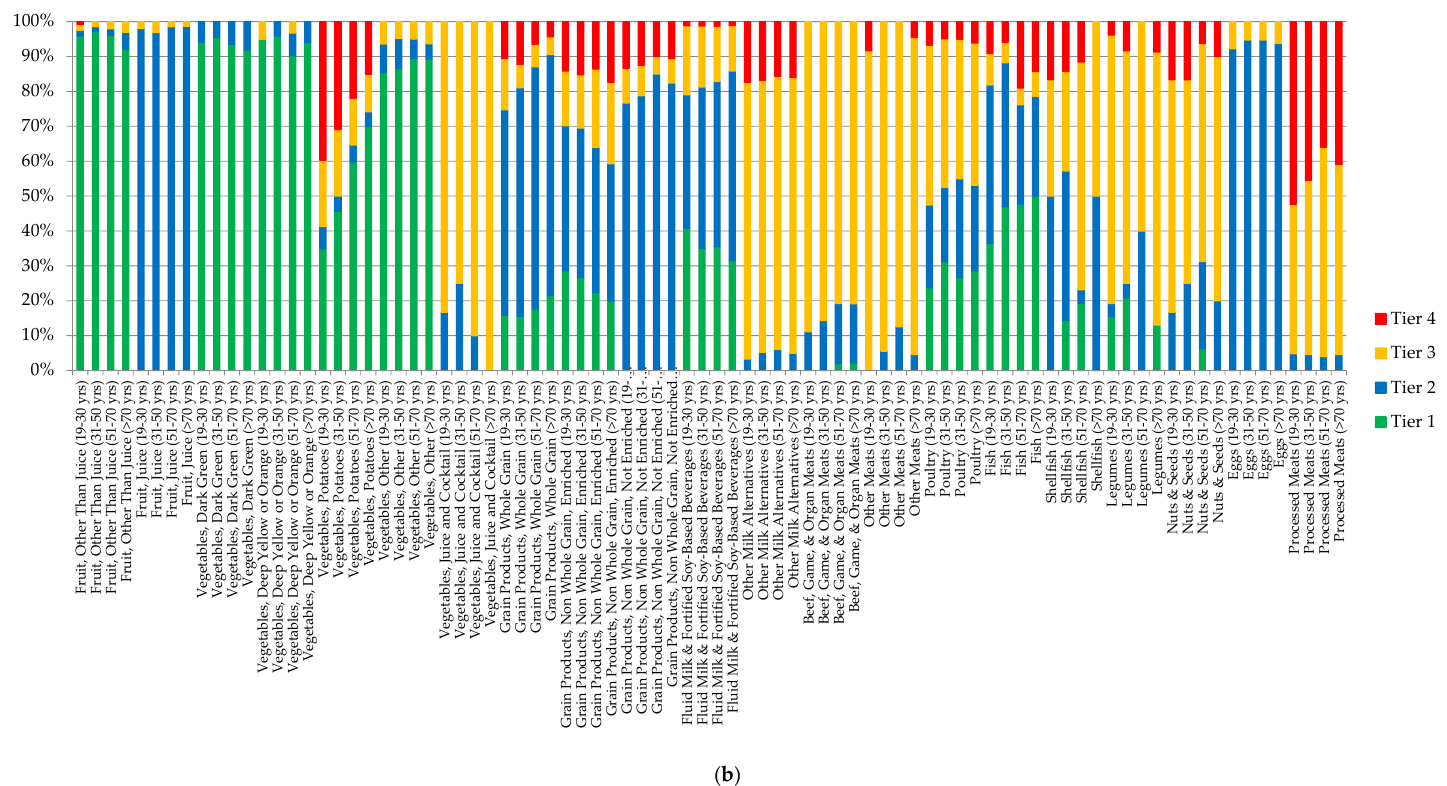
Figure 1. Weighted age ‐ stratified analysis of classification of foods as a percentage of servings based on the 2014 Health Canada Surveillance Tool Tier system among individuals ě 19 years * ,† in ( a ) Women and ( b ) Men. * Energy adjusted. † Tiers are based on Health Canada’s Surveillance Tool [9] and defined generally as follows: Tier 1–3 foods are compliant with EWCFG and Tier 4 foods are not recommended by the EWCFG. Tier 1 foods are foods that do not exceed lower thresholds for total fat, sugars, and sodium; Tier 2 foods do not exceed up to 2 lower thresholds for total fat, sugars or sodium, without exceeding any upper thresholds; for the Vegetables and Fruit and Grain Products food groups Tier 3 are foods that exceed all 3 lower thresholds without exceeding any upper thresholds or exceed only one upper threshold, while Tier 4 foods exceed at least 2 upper thresholds for total fat, saturated fat, sugars, or sodium. Within the Milk and Alternatives and Meat and Alternatives food groups, Tier 3 foods exceed all 3 lower thresholds without exceeding any upper thresholds for total fat, sugars, or sodium (irrespective of saturated fat) or exceed only one of these 3 thresholds or foods that only exceed the upper saturated fat threshold; within these 2 food groups foods that exceed at least 2 upper thresholds for total fat, sugars, or sodium were classified as Tier 4. Where lower thresholds entail: total fat ď 3 g/RA, sugars ď 6 g/RA, and sodium ď 140 mg/RA; and upper thresholds are: total fat >10 g/RA, sugars >19 g/RA, sodium >360 mg/RA, and saturated fat >2 g/RA. Full details are shown in Table S1.